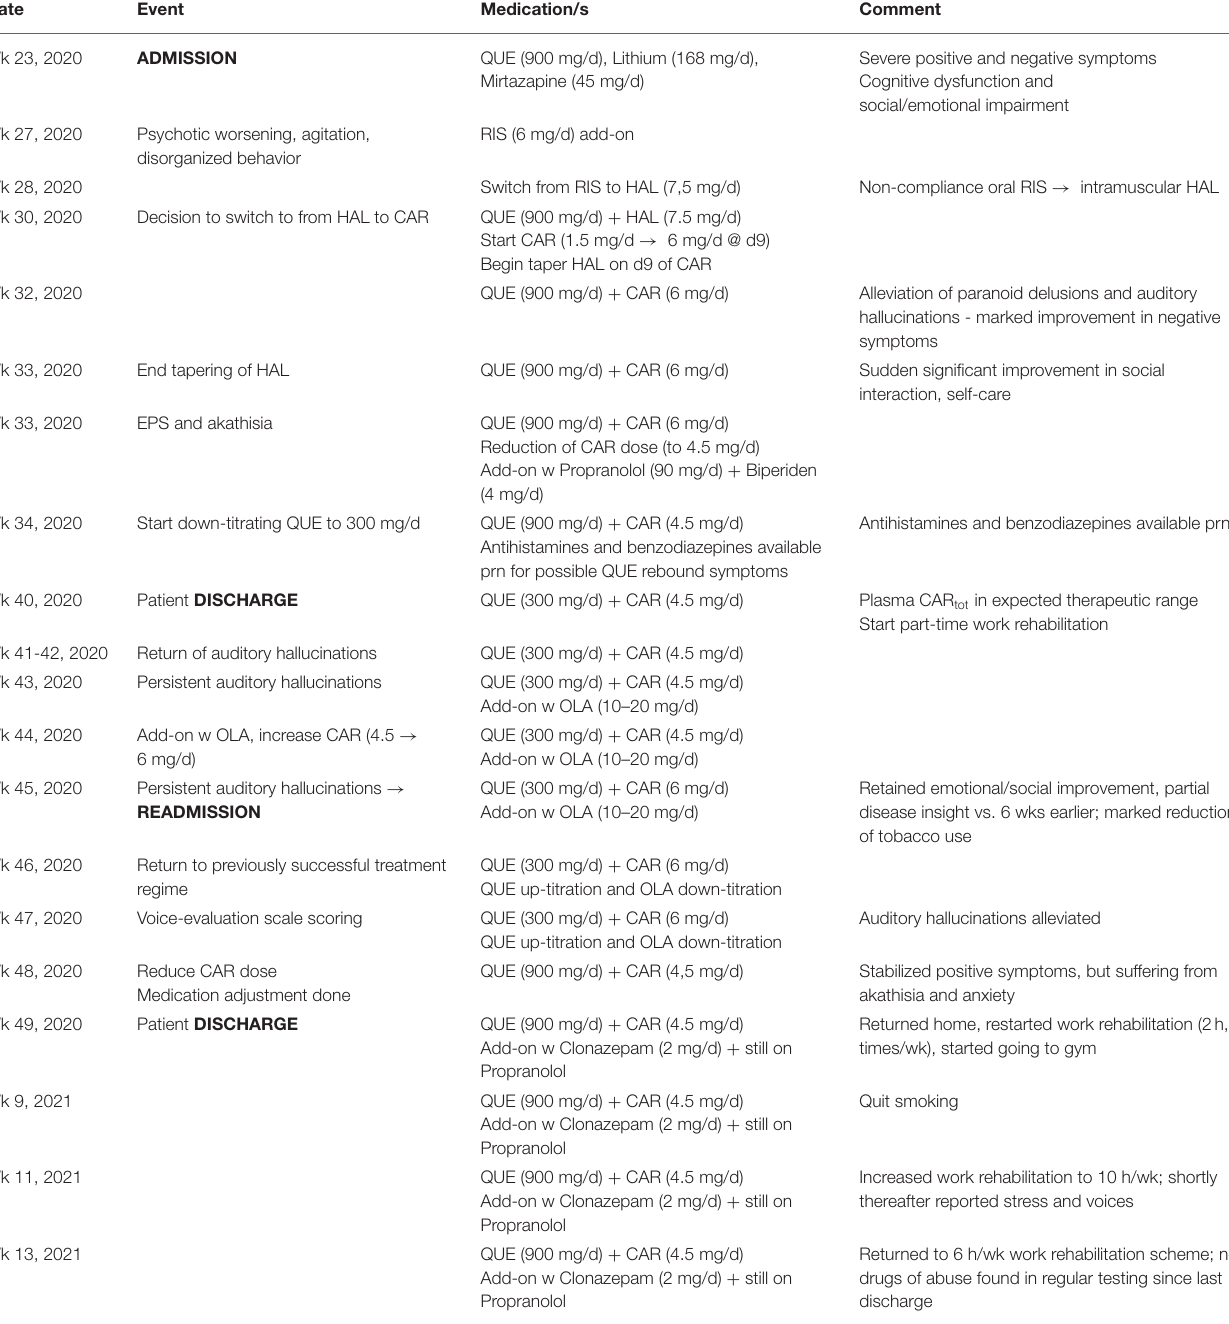
TABLE 2 | Timeline summary of patient events and medication across the current admission